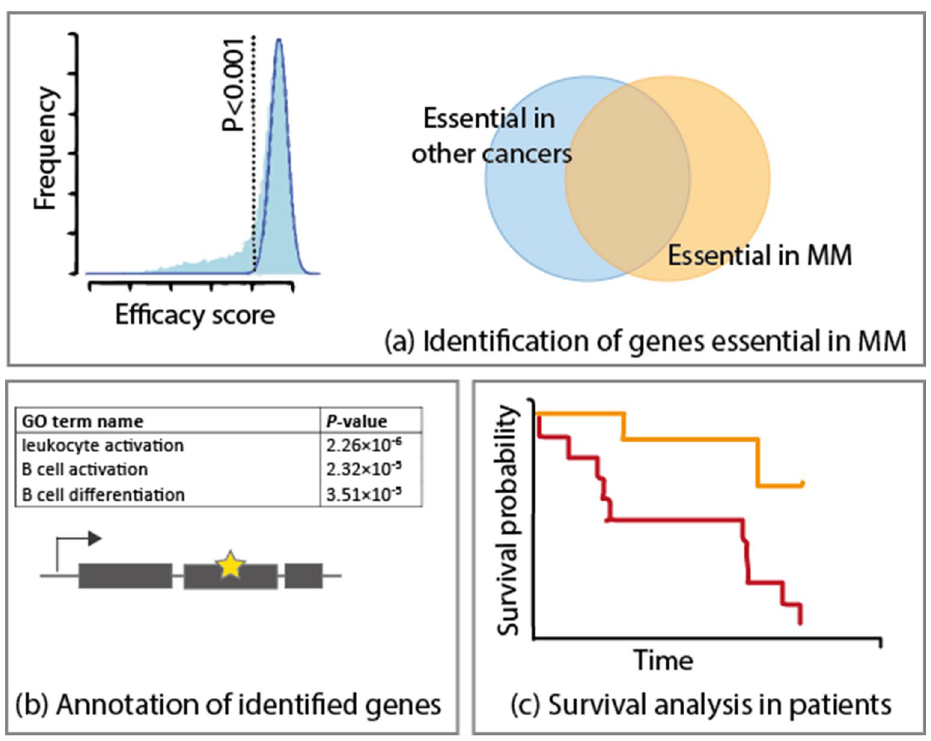
Figure 1. Overview of study design. ( a ) Identification of MM essential genes, ( b ) annotation of essential genes and ( c ) correlation of gene expression with patient